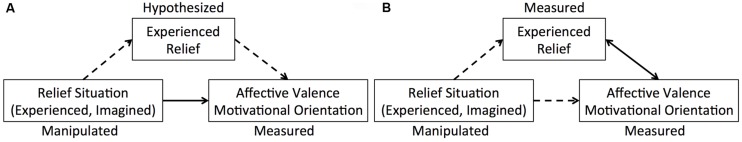
Situation based (A) and experience based (B) research strategies. Solid lines represent the main empirical inference, dashed lines represent hypothesized or optionally measured relations.